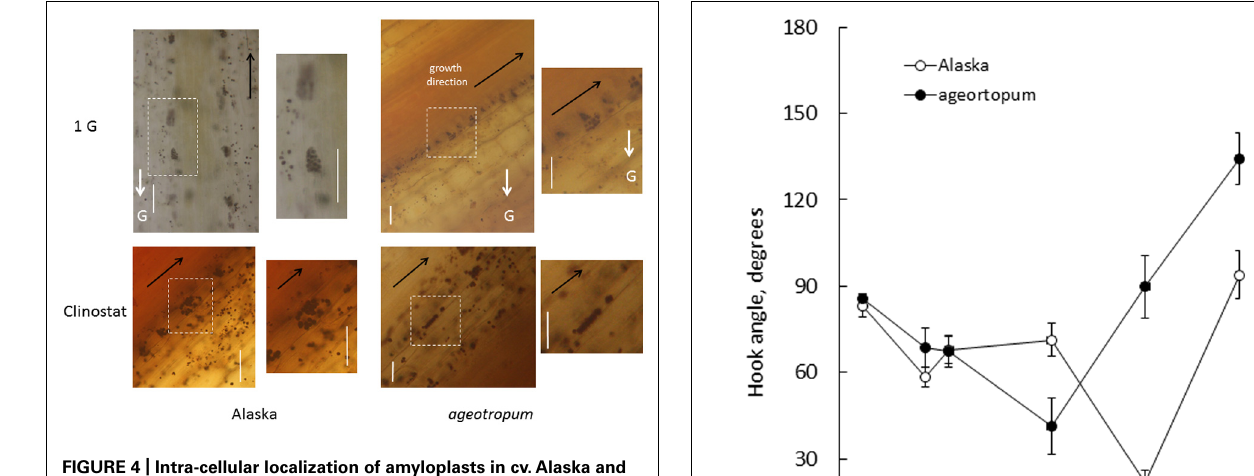
FIGURE 4 | Intra-cellular localization of amyloplasts in cv.Alaska and ageotropum under 1- g conditions and on a 3-D clinostat. The photographs are of sections prepared from the epicotyl part about 2 mm below the lower end of the apical hook. Dark violet stains are amyloplasts, which have sedimented along the direction of gravity, G-arrows, under the standstill 1- g conditions in cv. Alaska as well as ageotropum , but not on the clinostat; note that in ageotropum , gravity worked obliquely to the epicotyl since it slanted. Scale bars: 100 μ m.